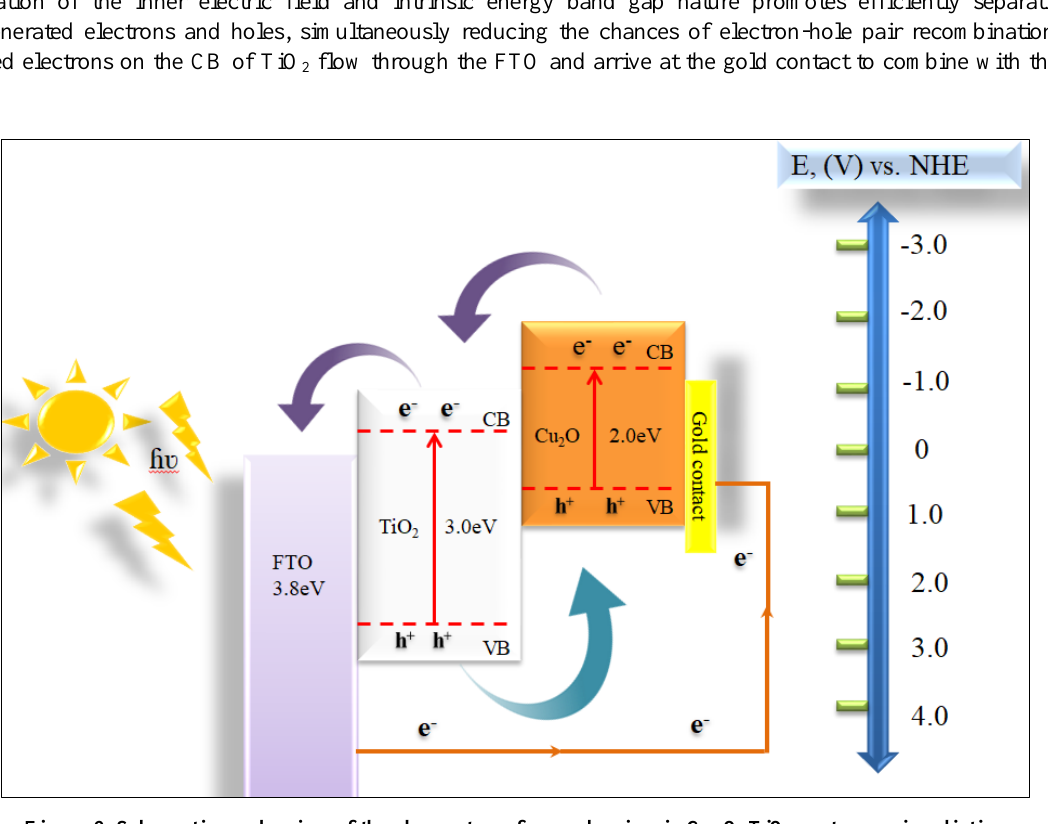
Figure 9. Schematic mechanism of the charge transfer mechanism in Cu 2 O-TiO 2 system on